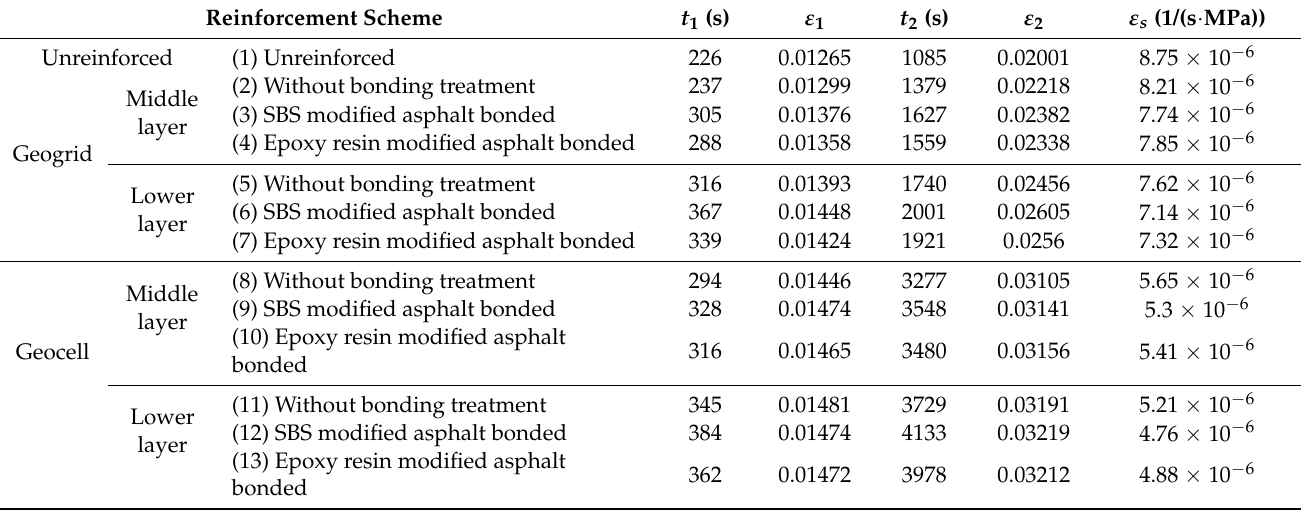
Table 7. Rutting depth and dynamic stability under different reinforcement